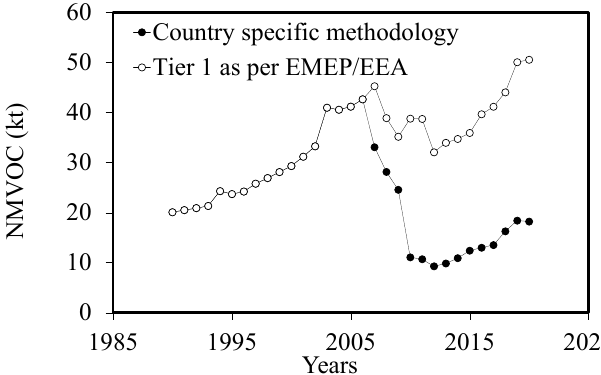
Figure 2. NMVOC emissions from coating applications.